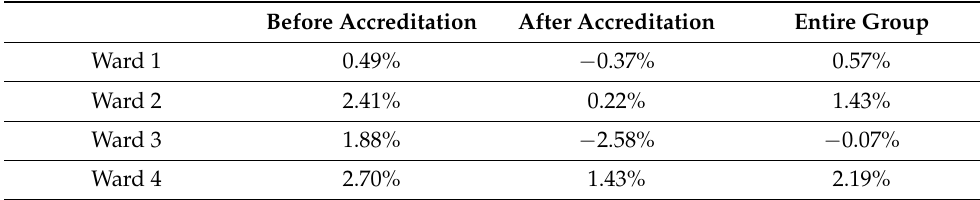
Table 3. Medium-term rate of change of the total